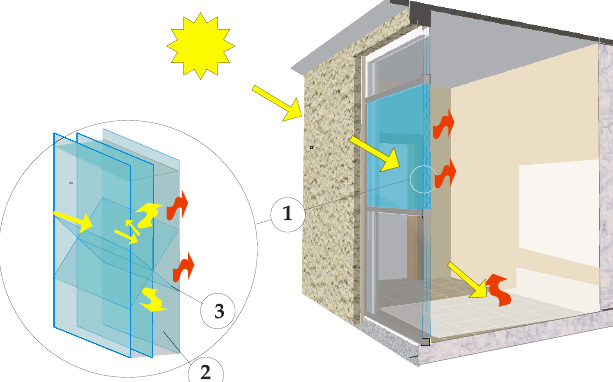
Figure 2. Water Trombe wall (transwall): 1—glass water container, 2—colored water, 3—diffusing-absorbing inserts.